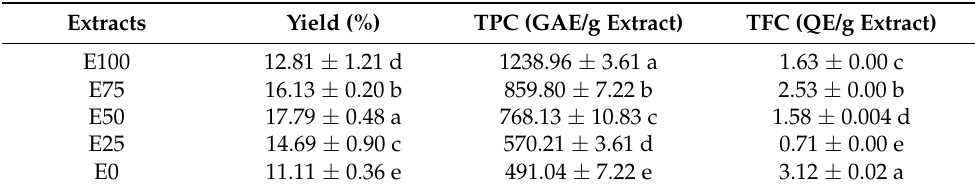
Table 1. Yield, phenolic, and flavonoid content of I. bijuga